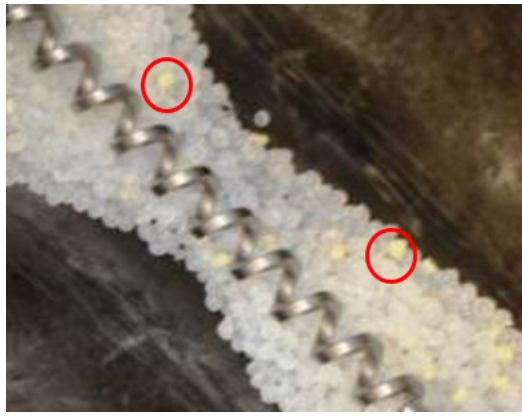
Figure 2 . Titanate coupling agent (shown in red circle) mixed with LLDPE pellets. Figure 2. Titanate coupling agent (shown in red circle) mixed with LLDPE